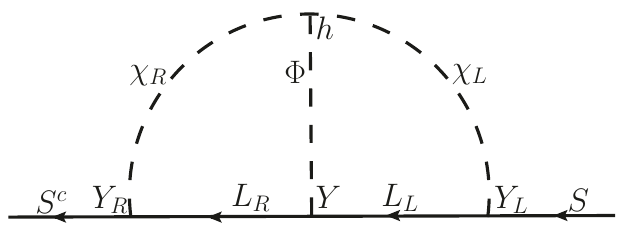
Figure 2 . The leading radiative correction to the Majorana mass (cid:22)